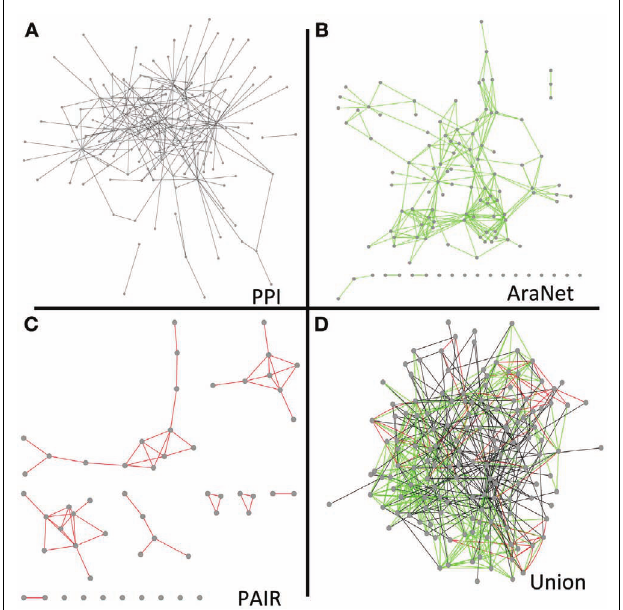
FIGURE 5 | Network diagrams of our final protein interaction network (without the Cub hubs) (A),AraNet (Lee et al., 2010) co-function links (B), PAIR DB (Lin et al., 2011) co-function links (C), and a union of the protein interaction,AraNet, and PAIR DB links (D) visualized by